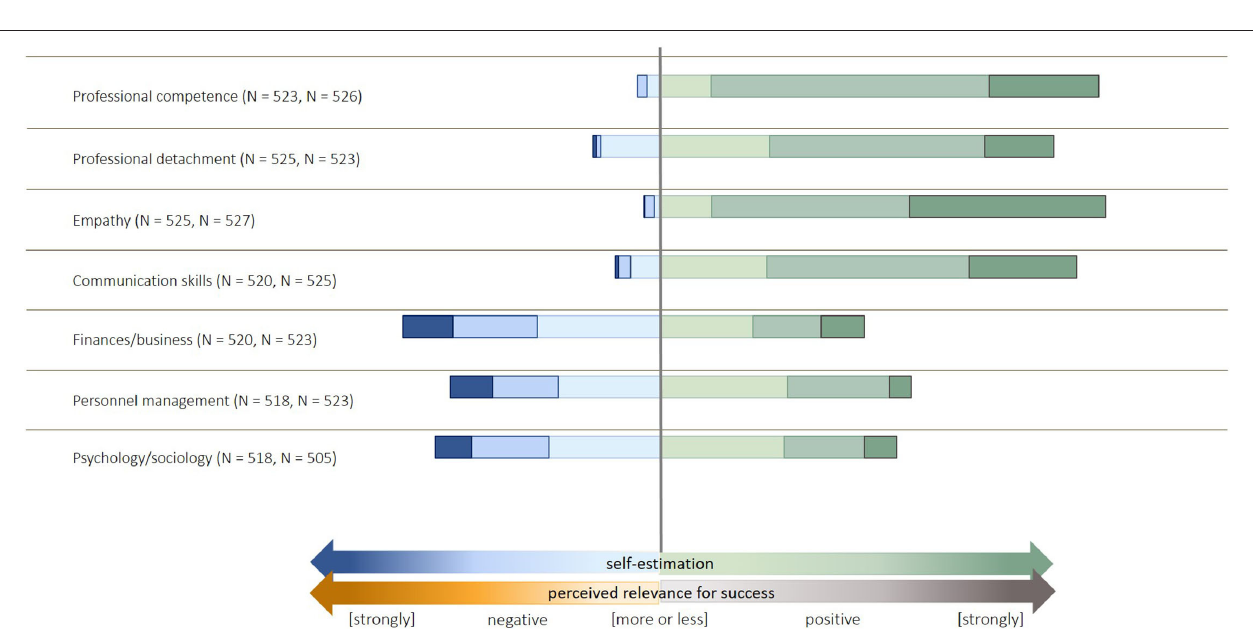
FIGURE 2 | Description of the items used to build the latent factor “expression of empathy” in the survey. The items were identified by an exploratory factor analysis and structural equation modeling, as described in Küper and Merle